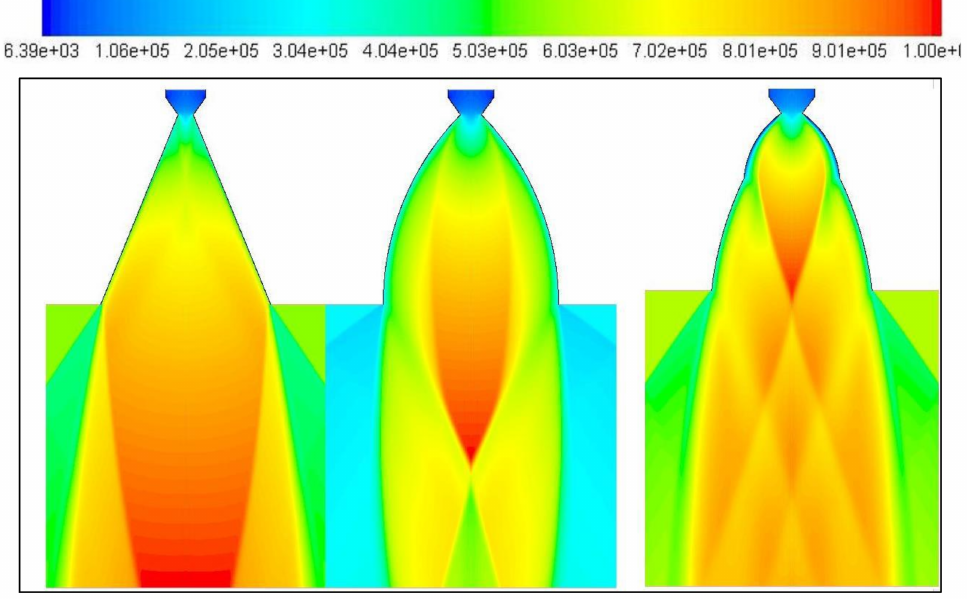
Figure 27. Pressure contours for conical, bell nozzle, and dual bell nozzle at 50,000 ft and Mach